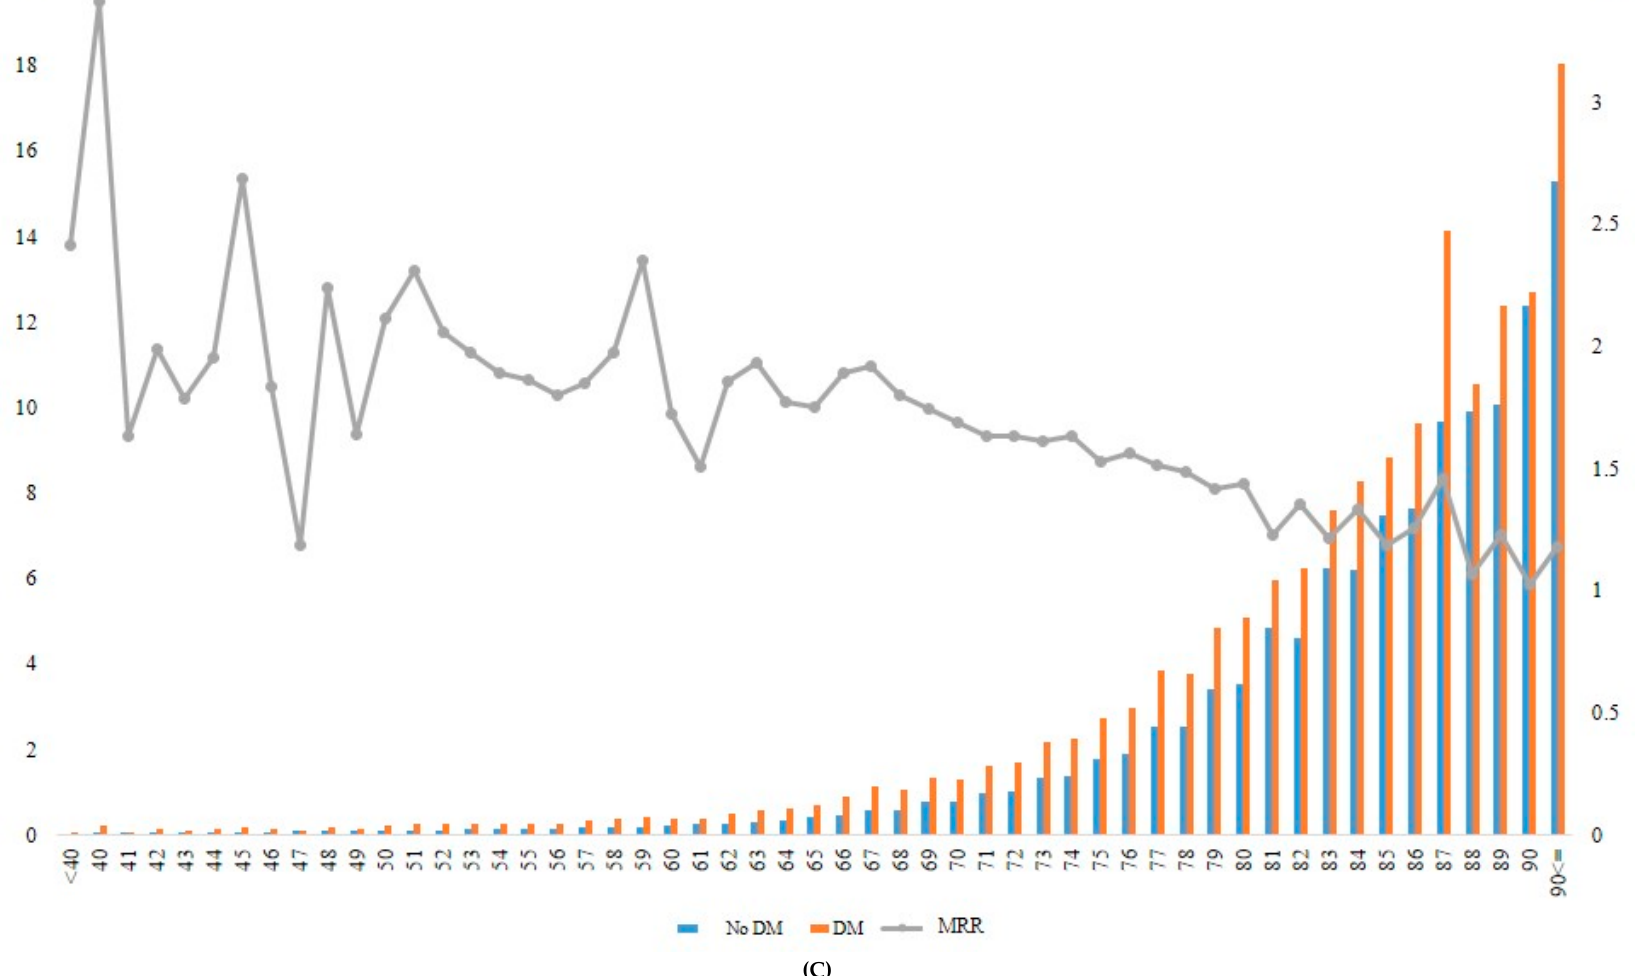
Figure 2. Incidence rate and MRR according to age groups in total ( A ), in men ( B ), and in women ( C ). DM, diabetes mellitus; MRR, mortality rate ratio.